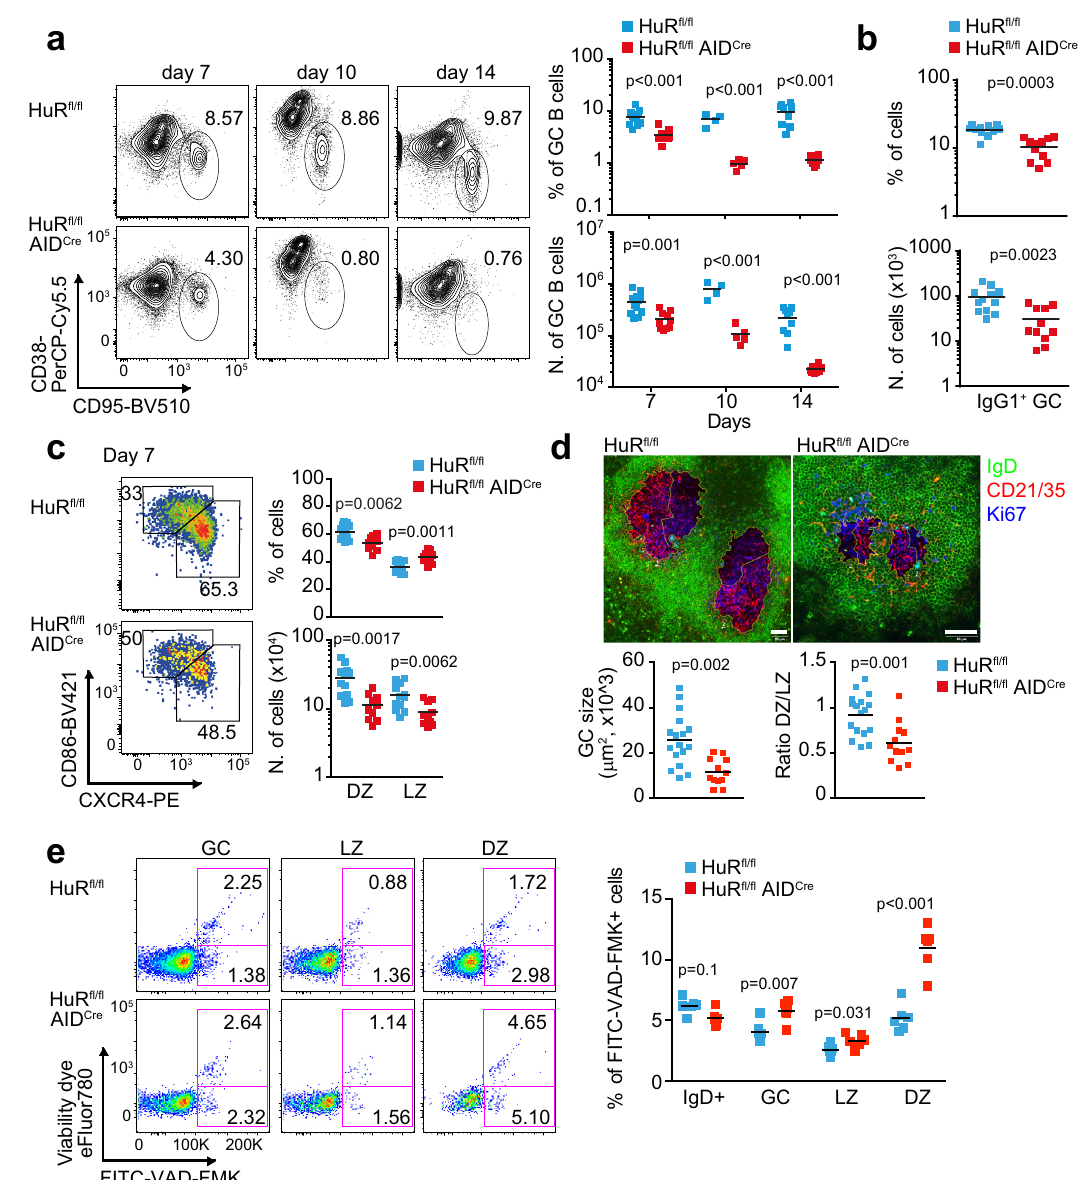
Fig. 2 HuR is essential for maintenance of the GC reaction. a Flow cytometric analysis of GC B cells in the spleen of HuR fl / fl and HuR fl / fl AID Cre mice at day 7, day 10 and day 14 after immunisation with NP-KLH in alum. Left panels, representative contour plots of CD95 + CD38 − GC B cells (previously gated on CD19 + IgD − cells). Right panels, the percentage and number of GC B cells (data representative from 1 of at least 3 independent experiments performed at each time point, n = 4 – 12 mice per group depending on the day of the analysis, two-sided Mann – Whitney test). b Percentage and number of IgG1 + GC B cells in HuR fl / fl and HuR fl / fl AID Cre mice at day 7 after immunisation (GC B cells gated on CD19 + IgD − CD38 − CD95 + ). c Analysis of DZ and LZ GC B cells at day 7 after immunisation in mice shown in b . Left panels, representative contour plots of CXCR4 + CD86 − DZ GC B cells and CXCR4 − CD86 + LZ GC B cells (previously gated on CD19 + IgD − CD38 − CD95 + ). Right panels, quantitation of the percentage and number of DZ and LZ GC B cells Data in b , c are from 2 independent experiments, n = 12 (HuR fl / fl ) and n = 11 (HuR fl / fl AID Cre ) mice, two-sided Mann – Whitney test. d Visualisation by confocal microscopy of GC size and GC B cell distribution in HuR fl / fl and HuR fl / fl AID Cre mice at day 7 after immunisation (scale bar = 50 μ m). Bottom panels, quantitation of the GC size and the ratio DZ/LZ quanti fi ed upon staining of the DZ with Ki67 (in blue) and the LZ with CD21/35 (in red). n = 17 (HuR fl / fl ) or n = 12 (HuR fl / fl AID Cre ) GCs examined from 2 immunised mice per genotype over 2 independent experiments (two-sided Mann – Whitney test). e Representative pseudo-colour plots showing the staining with the viability dye eFluor780 and FITC-VAD-FMK of the different GC B cell populations in the spleen of HuR fl / fl and HuR fl / fl AID Cre mice at day 10 after immunisation with NP-KLH alum. Right panel, quantitation of the percentage of B cells positive for FITC-VAD-FMK ( n = 6 mice per group, 2-way ANOVA and Bonferroni ’ s post-test). Source data are provided as a Source data fi le. (Supplementary Fig. 2d). DZ GC B cells showed the highest viable LZ GC B cells was similar in HuR fl / fl AID Cre mice proportion of non-viable cells. The percentage of DZ GC B cells compared to control mice at day 7 after immunisation labelled with FITC-VAD-FMK and/or the viability dye was (Supplementary Fig. 2c), but it was increased 1.4-fold at day 10 signi fi cantly increased in the absence of HuR at all times analysed (Fig. 2e) and 5-fold at day 14 in HuR fl / fl AID Cre mice (Supplementary Fig. 2c). Taken together, HuR is required for following immunisation. By contrast, the percentage of non- NATURE COMMUNICATIONS| (2021) 12:6556